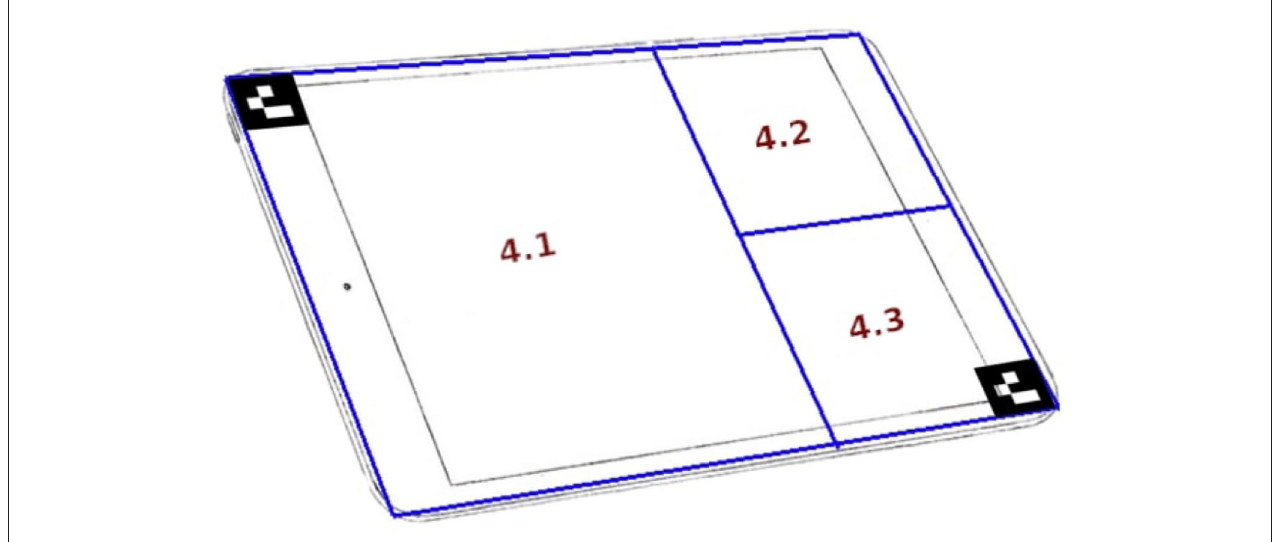
FIGURE 5 | U-track application sub-areas of